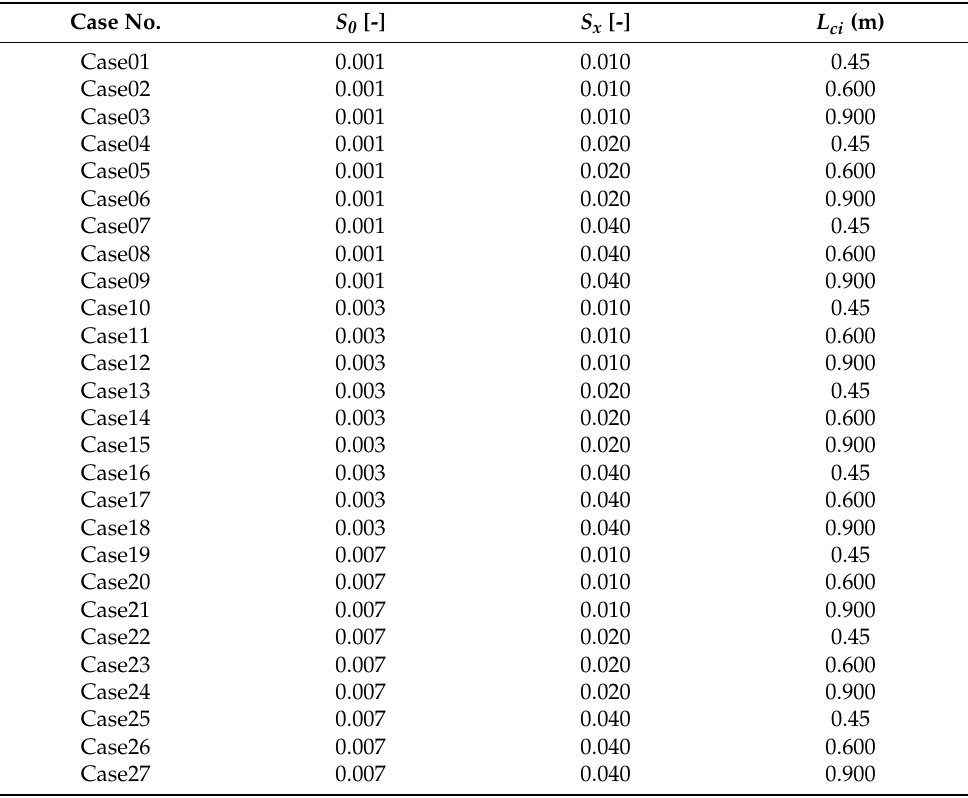
Table 2. Parameters of modeling cases for RB stripes with three types of curb inlet. Case No. S 0 [-] S x [-] L ci (m) Case01